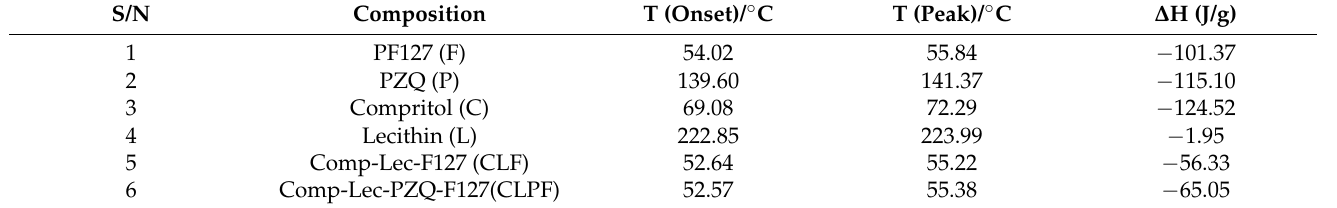
Table 2. The summary of the DSC thermogram data of all the excipients and the formulated unloaded and PZQ-loaded SLNs.